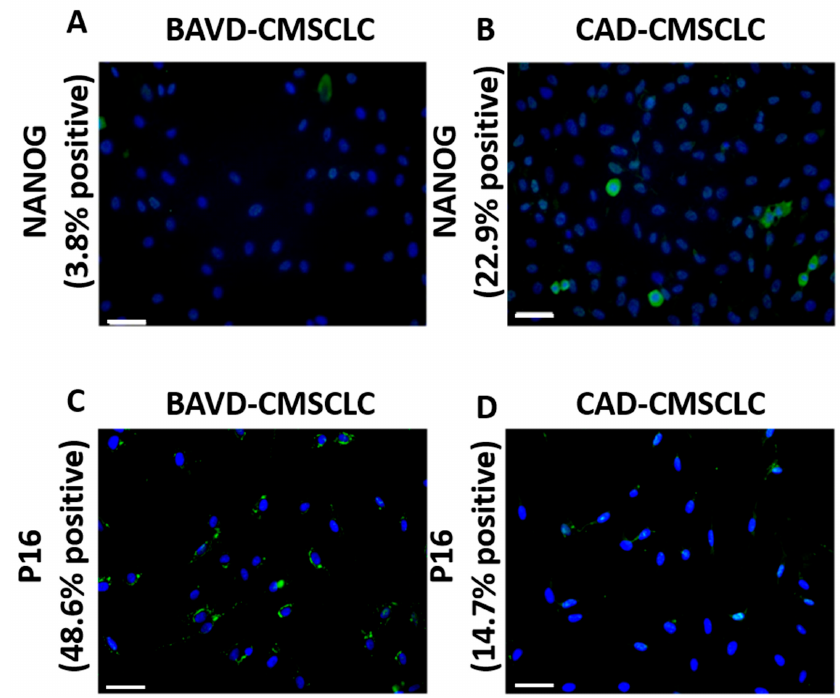
Figure 3. Immunolabelling of CMSCLC for NANOG and p16. ( A , B ) ICC analysis for NANOG expression in BAVD-CMSCLC and CAD-CMSCLC. NANOG (Green), all nuclei labelled with Dapi (Blue). ( C , D ) ICC analysis for p16 expression in BAVD-CMSCLC and CAD-CMSCLC. p16 (Green), all nuclei labelled with DAPI (Blue). Scale bar = 50 μ m.